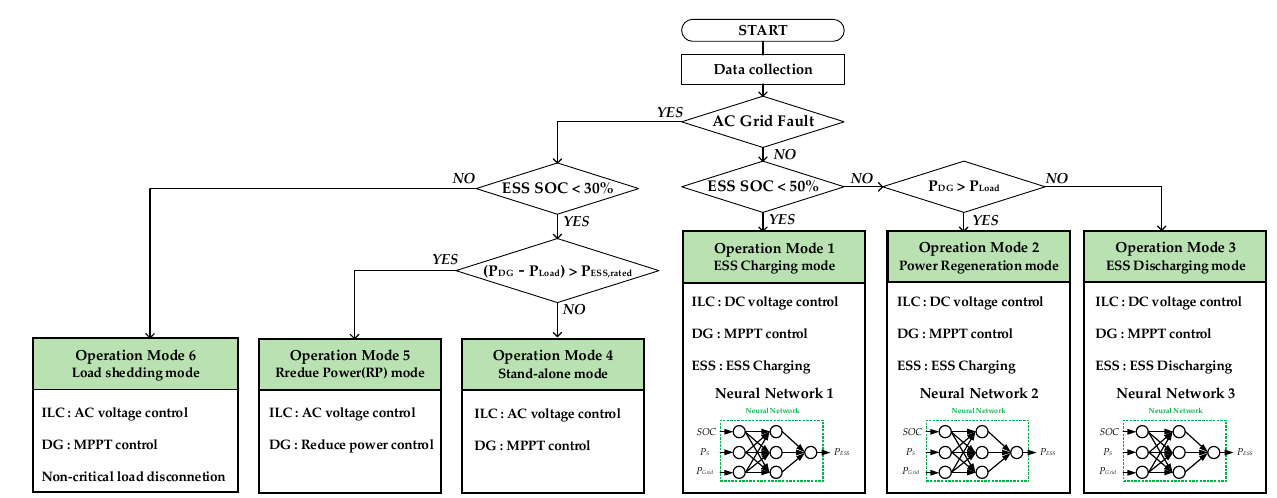
Figure 5. Flowchart of the proposed EMS.